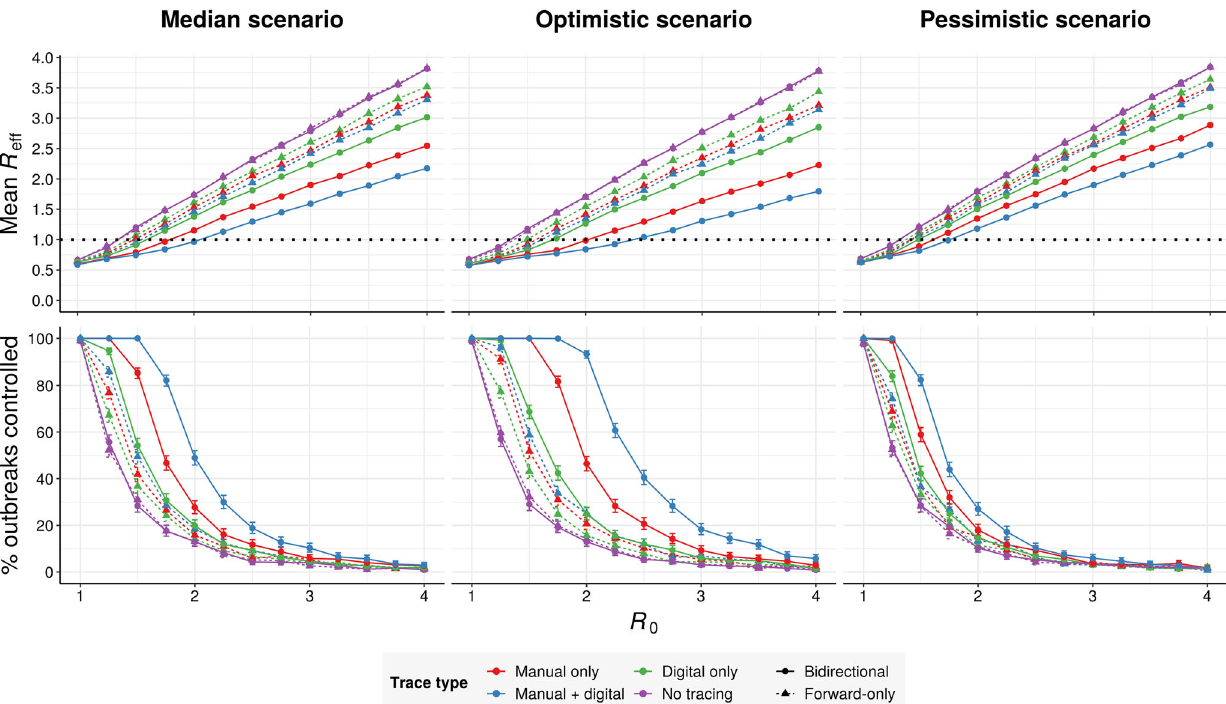
Fig. 4 Effect of R 0 and disease parameters on performance. (top row) Mean R eff achieved and (bottom row) mean % of outbreaks controlled by different tracing strategies as a function of the basic reproduction number R 0 , assuming (left) median, (middle) optimistic or (right) pessimistic disease parameters (Table 1), assuming 50% ascertainment of symptomatic cases, 70% test sensitivity, 90% probability of trace success, a 6-day manual tracing window, and high (80%) smartphone coverage (Table 1). Error bars in the bottom row represent 95% credible intervals across 1000 runs under a uniform beta prior. Isolation on the basis of symptoms can dampen the outbreak at low R 0 , even in the absence of